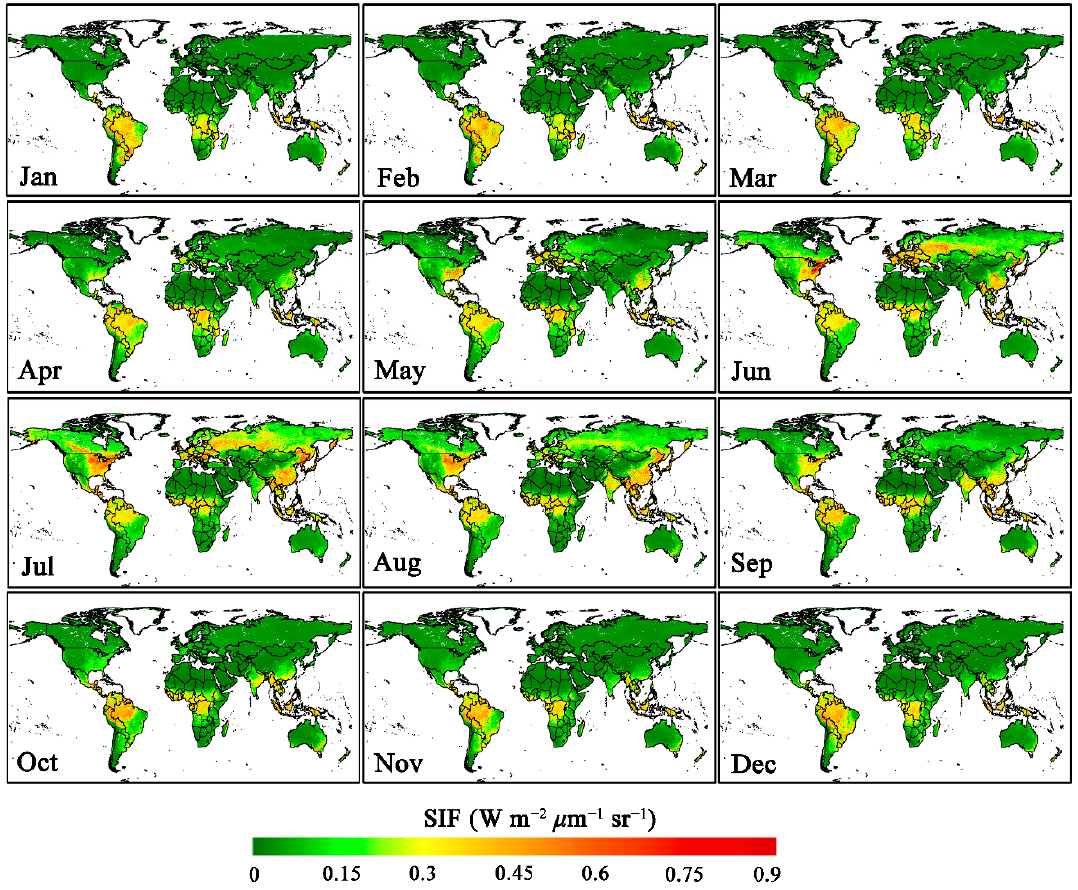
Figure 6. Spatial patterns of 8-day global OCO-2 SIF (GOSIF) from January through December in 2016. The units are W m − 2 µ m − 1 sr − 1 . For each month, the second 8-day SIF map is shown here. Our new 0.05 ◦ SIF captured the seasonal variations presented in the 1 ◦ OCO-2 SIF maps directly aggregated from discrete soundings at four selected EC sites fairly well (Figure 7a,c,e,g). Compared to the discrete and noisy observations (likely due to the scale mismatch) found in the coarse-resolution maps, the continuous and smooth observations in our new SIF could support finer-scale